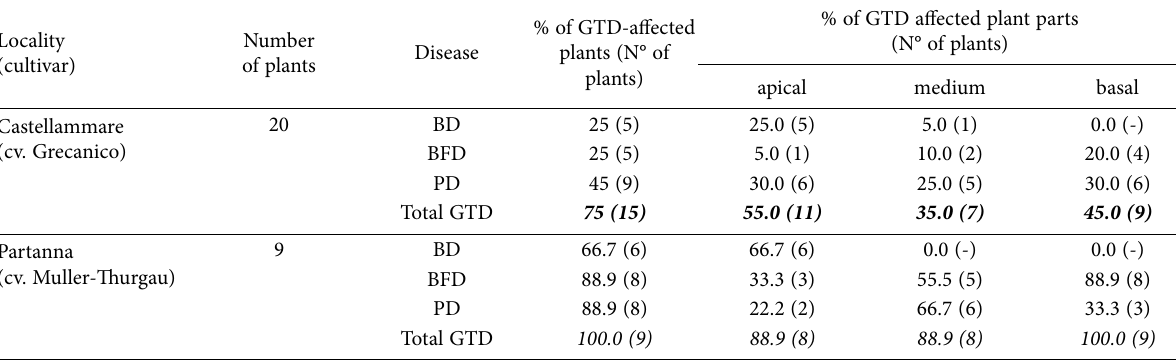
Table 2. Incidence (%) of the different grapevine trunk diseases (GTDs) in whole grapevine plants and in plant parts of cvs Grecanico and Muller-Thurgau from two localities in Sicily. BD = Botryosphaeria dieback, BFD = black foot disease, PD = Petri disease. Percentages were calculated from the number of plants showing symptoms (in brackets) and the total number of samples per vineyard.